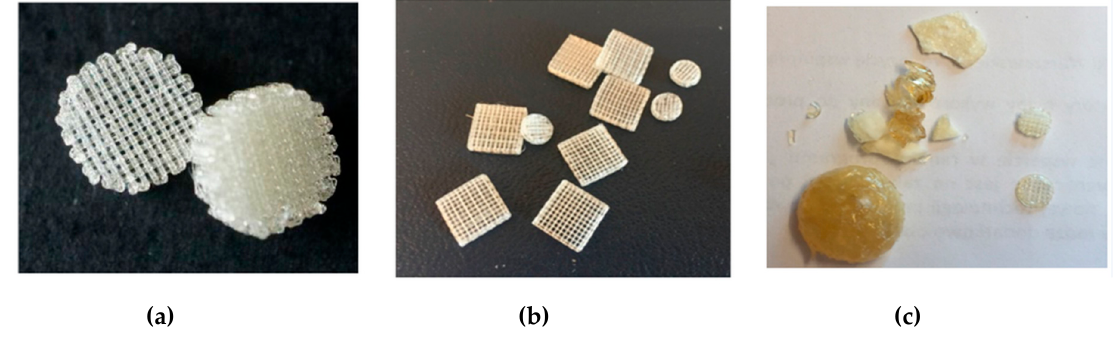
Figure 7. Three-dimensional moulds obtained by fused deposition modelling (FDM) of ( a ) P(iPrOx– nPrOx) 12k , ( b ) P(iPrOx–nPrOx) 51k and ( c ) PiPrOx 21k together with a fraction of the polymer that blocked the